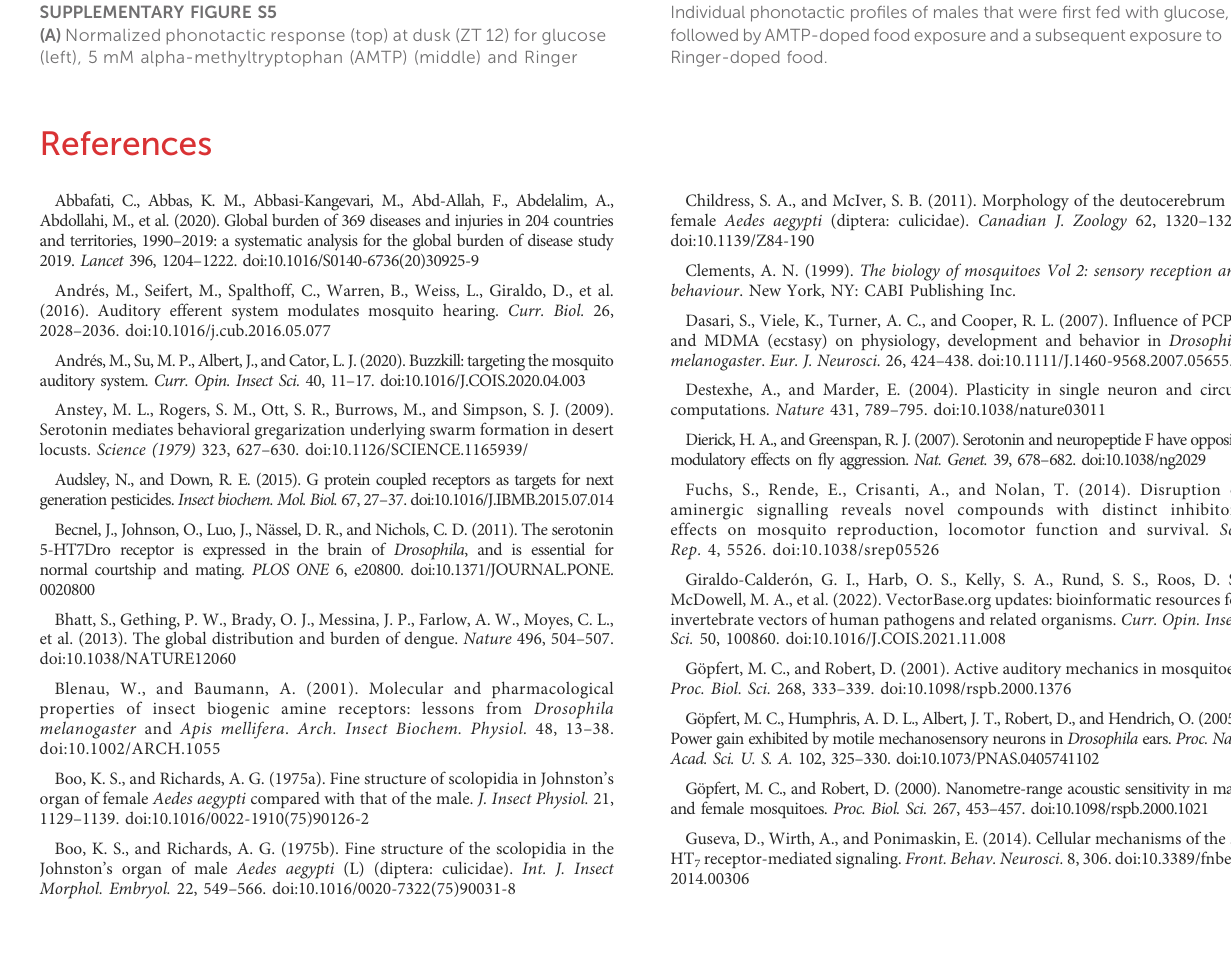
(right) fed male mosquitoes. Bars represent median values for each frequency, error bars represent SEM, and small dots represent individual repeats. Changes in the areaunder thecurve (AUC)of male phonotactic pro fi le (bottom left) when males were provided with glucose, 5 mM AMTP-doped food or Ringer-doped food. Changes in the frequency range to which males showed response to (bottom right) when provided with glucose, 5 mM AMTP-doped or Ringer- doped food. Lower and upper frequency boundaries are shown. Bars represent median values, dots represent individual repeats and data collected from a single repeat are connected with dotted lines. (B) Normalized phonotactic response of males (left) tested at dawn (ZT 0) (left) and dusk (ZT 12) (right). Bars represent median values for each frequency, error bars represent SEM, and dots represent values from individual repeats. Individual male phonotactic pro fi les collectedatdawn (ZT 0) anddusk (ZT 12)(toprightand bottom right). SUPPLEMENTARY FIGURE S6 (A) Median Δ Frequency data for Ringer and 25 mM 5- hydroxytryptophan (5-HTP) male injection groups. Signi fi cant differences identi fi ed via ART ANOVA between groups are labelled. Dotsrepresentmedian Δ Frequency for individuals. Injection occurred immediately after the fi rst recording at zero min. Bar represents the median of the median Δ Frequency for each group. ***, P ≤ 0.001. (B) Individual time series for changes in male fl agellar ear mechanical frequency tuning following 25 mM 5-HTP injection. Dots represent frequency values extracted from collected data. Solid lines represent loess fi ts to these data points. SUPPLEMENTARY FIGURE S7 (A) Individual phonotactic pro fi les of males that were fi rst fed with glucose, followed by exposure to Ringer-doped food. (B) Individual phonotactic pro fi les of males that were fi rst fed with glucose, followed by exposure to 5 mM alpha-methyltryptophan (AMTP)-doped food. (C) Individual phonotactic pro fi les of males that were fi rst fed with